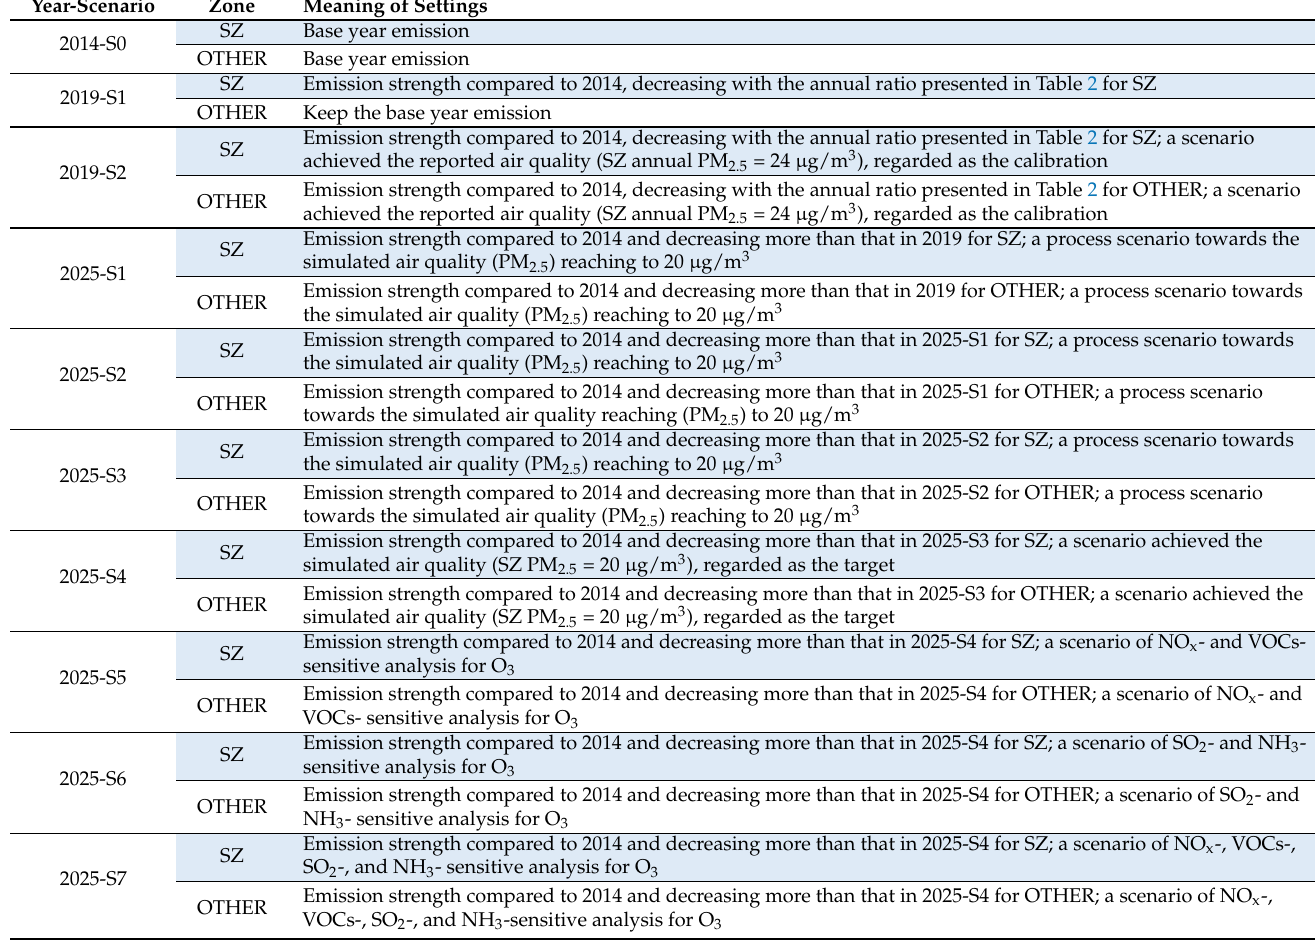
Table 6. Meaning of each